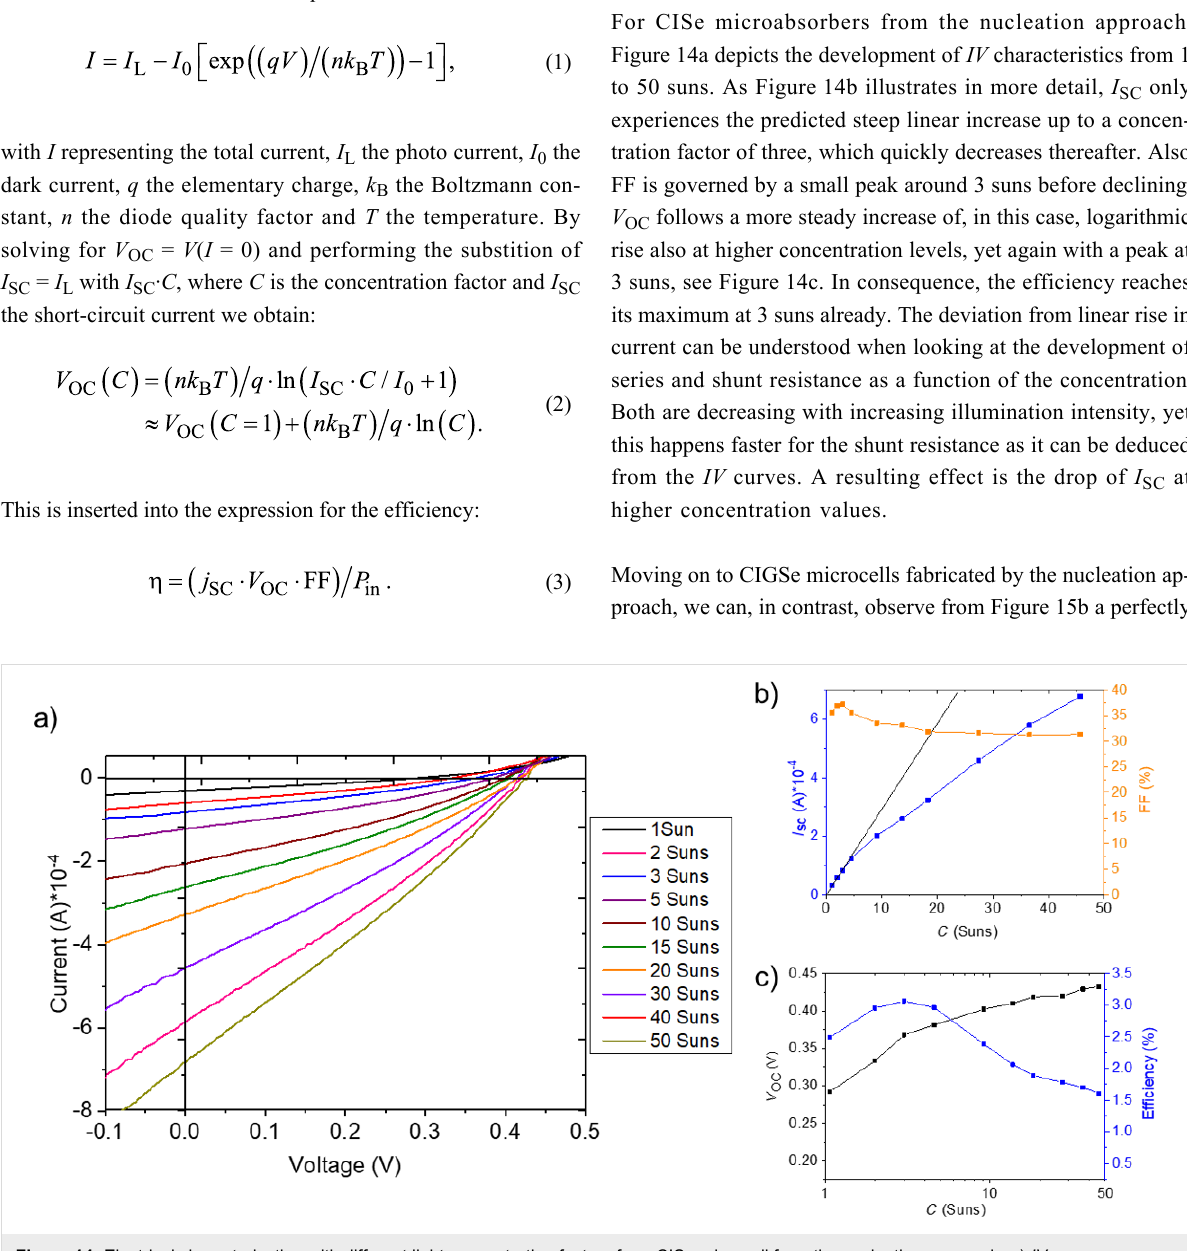
Figure 14: Electrical characterization with different light concentration factors for a CISe microcell from the nucleation approach: a) IV curves, b) I SC and FF, c) V oc and η